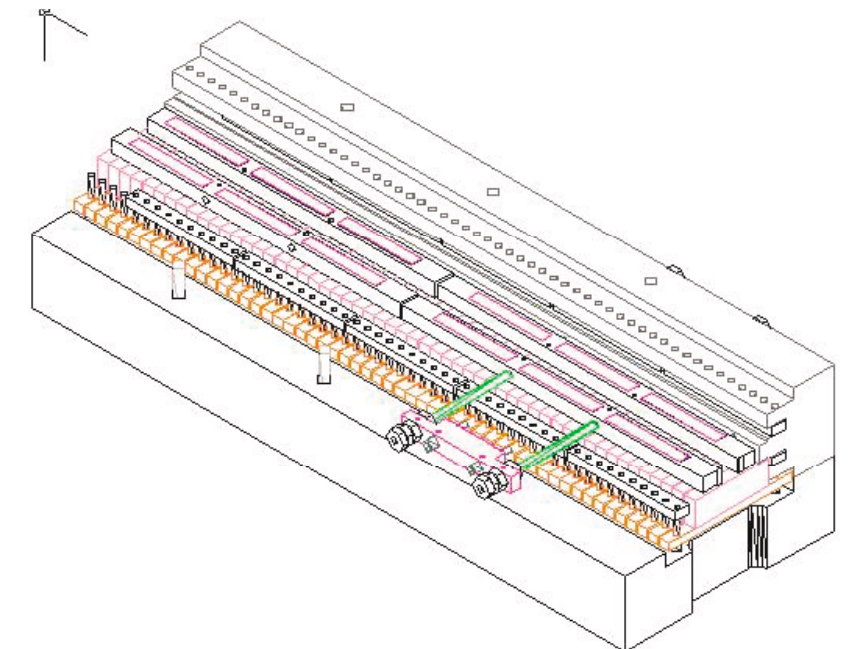
FIG. 5. (Color) Cutaway view of the VISA undulator showing the lower row of dipole magnets and the quadrupole assemblies above them. The adjustor assembly with green rods was first designed only to provide horizontal motion and was later modified with cams on the ends of the rods to move the focusing magnet assemblies in the